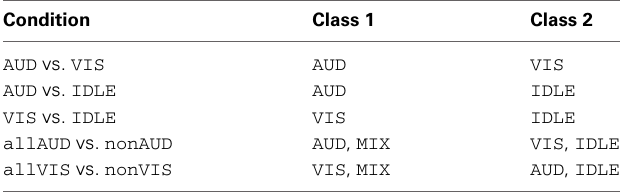
Table 1 | Binary classification conditions for evaluation.